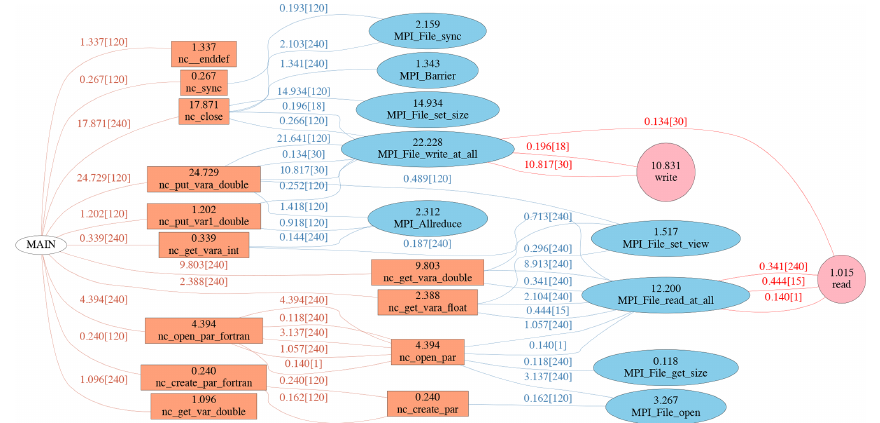
Figure 11. The call path flow of tuned 240 PE benchmark with HDF5 1.10.2/netCDF-4. It is classified into three layers, i.e. netCDF, MPI-IO and system I / O functions. The maximum PE time together with the total number of PEs from the invoker are labelled above each path line, and the maximum PE time on each function are labelled within the node